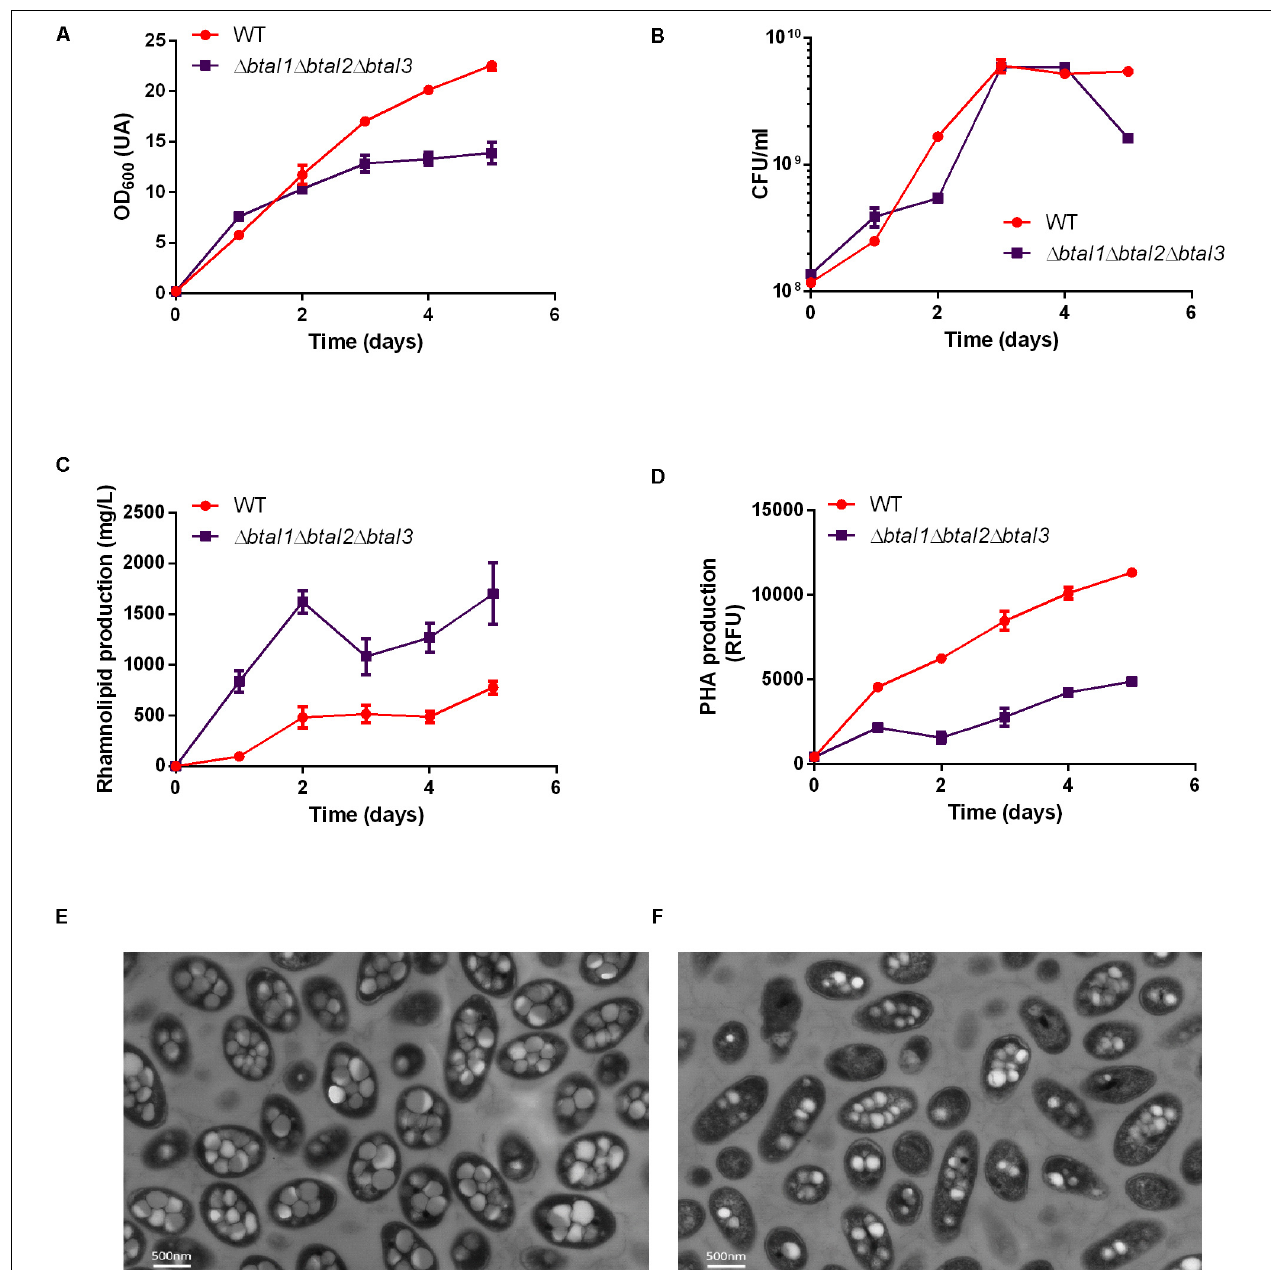
FIGURE 7 | Rhamnolipid and PHA production are quorum sensing-controlled. The wild type strain and the (cid:49) btaI1 (cid:49) btaI2 (cid:49) btaI3 quorum sensing mutant were cultured for five days at 30 ◦ C in NB medium supplemented with 2% glycerol. The (A) OD 600 , (B) CFU/mL, (C) PHA levels, and (D) rhamnolipid concentration measurements are represented. Values are means ± standard deviations (error bars) for three replicates. TEM images were taken at day 4 for panels (E) the wild type strain and (F) the (cid:49) btaI1 (cid:49) btaI2 (cid:49) btaI3